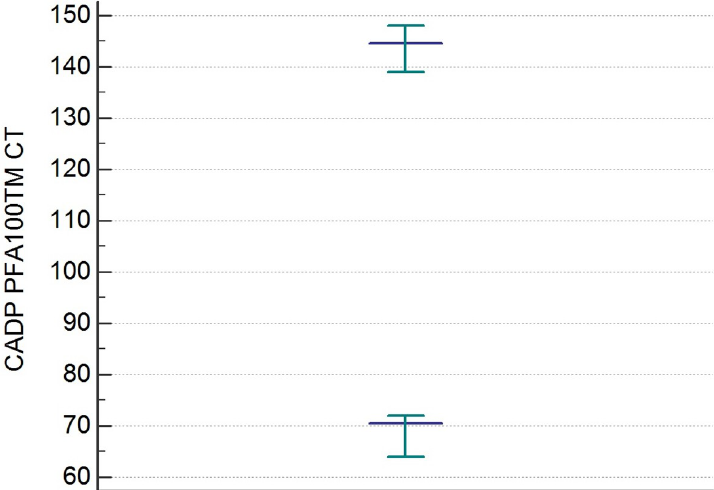
Fig 2. Reference intervals of CADP PFA-100 CT determined by non-parametric percentile method (CLSI C28-A3).